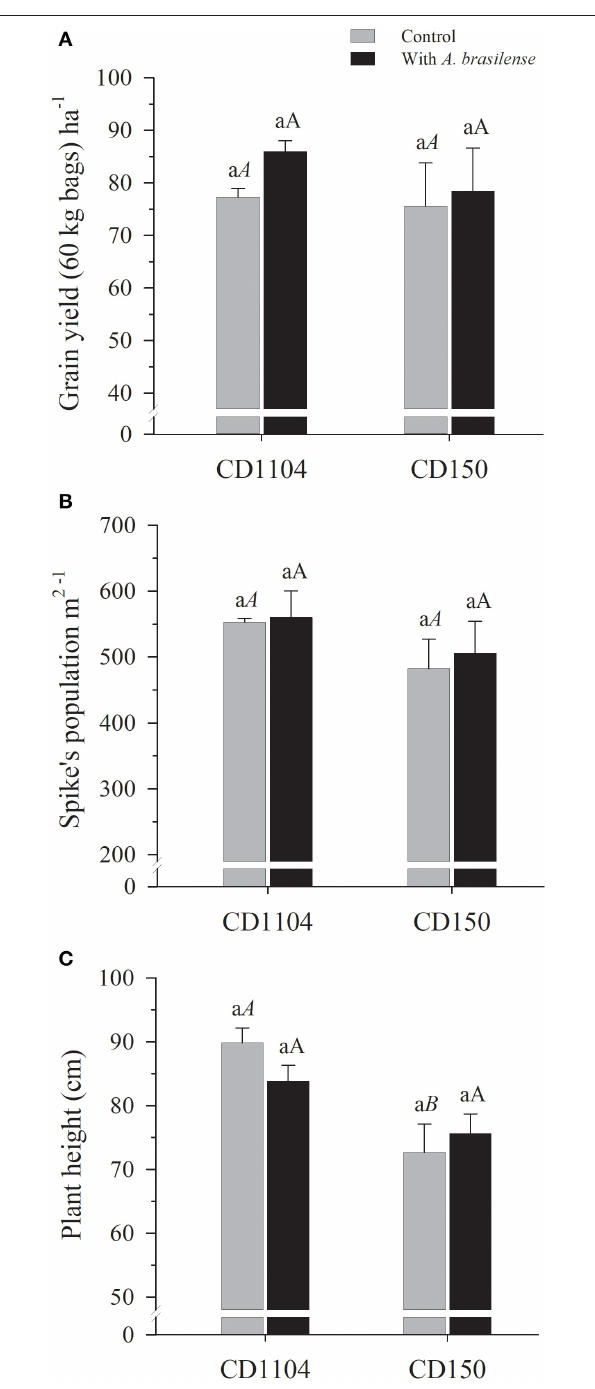
FIGURE 6 | Grain yield (A) , spike population (B) , and plant height (C) of the wheat cultivars CD1104 and CD150 subjected to inoculation with A. brasilense . Different letters indicate difference between means according to a Tukey test ( p ≤ 0.05). Lowercase letters correspond to cultivars within each inoculation level, and uppercase letters correspond to inoculations within each cultivar level. Identical letters do not differ from each other according to a Tukey test ( p ≤ 0.05). CV (%) = 10.6 (A) , 12.86 (B) , 12.9 (C) . Error bars indicate the standard error of the mean ( n = 6